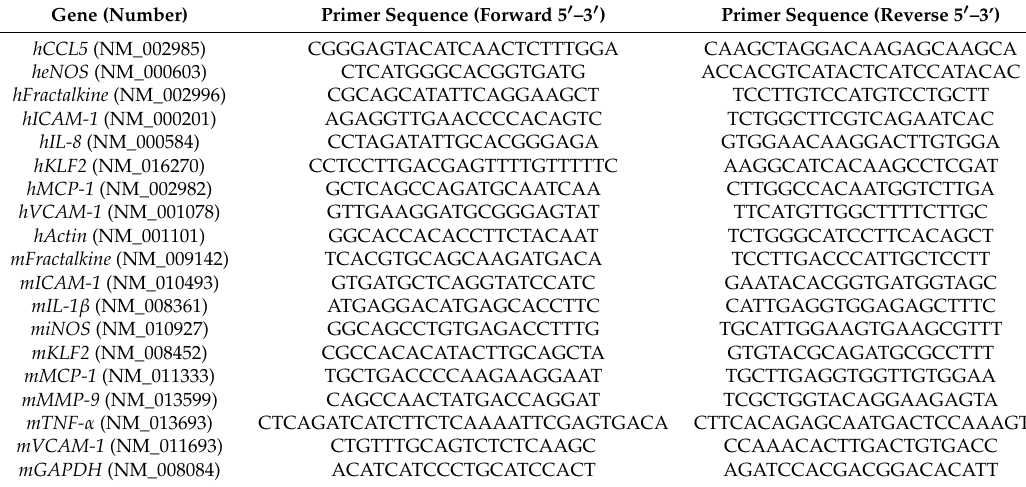
Table 1. Sequences of primers used in real-time qRT-PCR